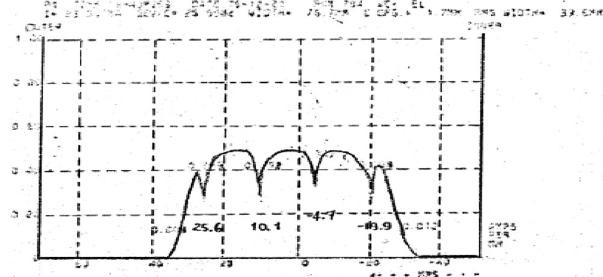
apparent.FIG. 14. Resulting measurement of the working